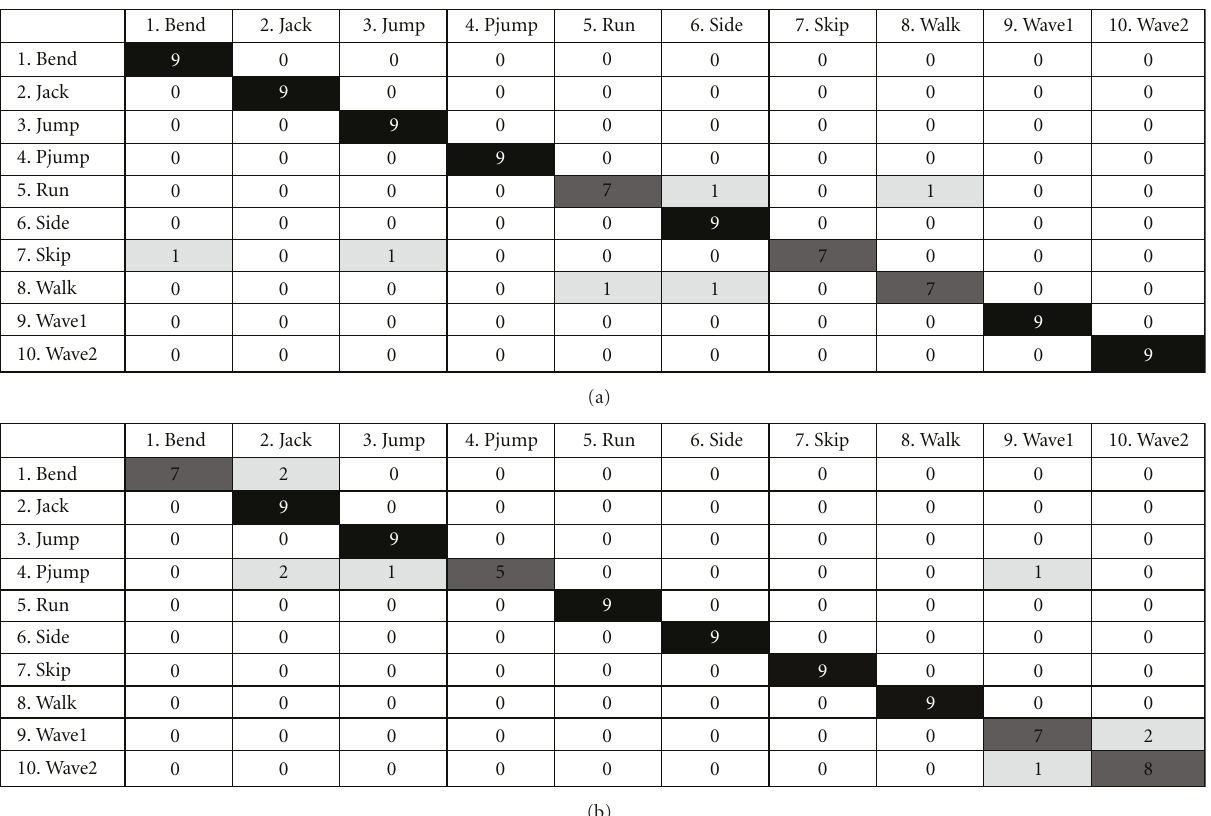
Figure 10: (a) Confusion matrix of the distance signal feature using 128 codewords. (b) Confusion matrix of the width feature using 128